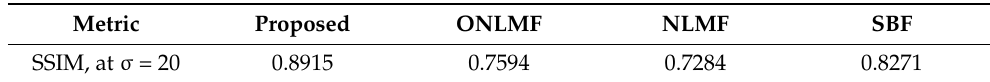
Table 1. SSIM values for several algorithms using database images. NLMF, non-local means filter; ONLMF, optimized non-local means filter; SBF, switching bilateral filter; SSIM, self-similarity index metrics; σ , Gaussian blur standard deviation. Metric Proposed ONLMF NLMF SBF SSIM, at σ = 20 0.8915 0.7594